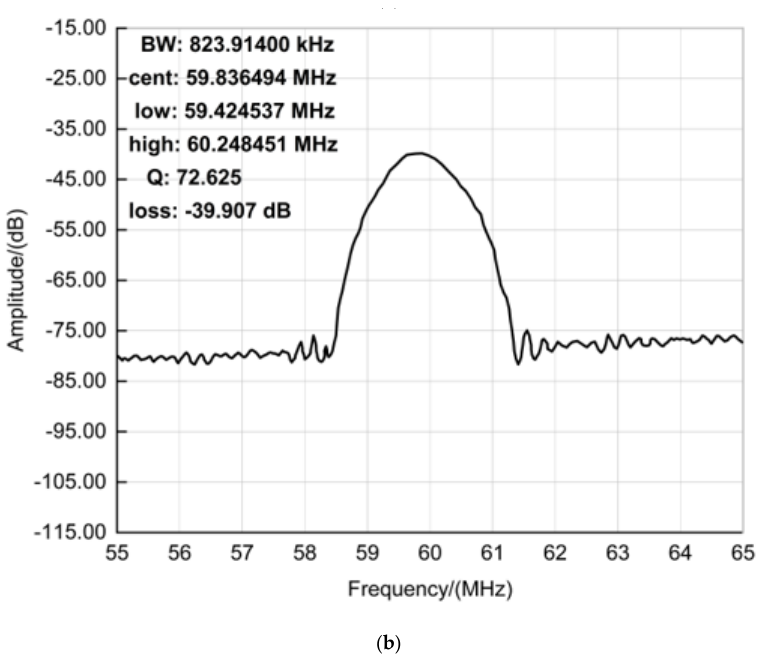
Figure 6. Frequency characteristics of the acoustic surface wave devices. ( a ) SAW − 1; ( b ) SAW − 2.